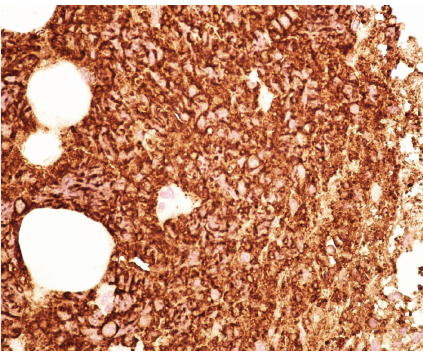
Figure 4: Lymphoma cells are strongly immunoreactive to CD